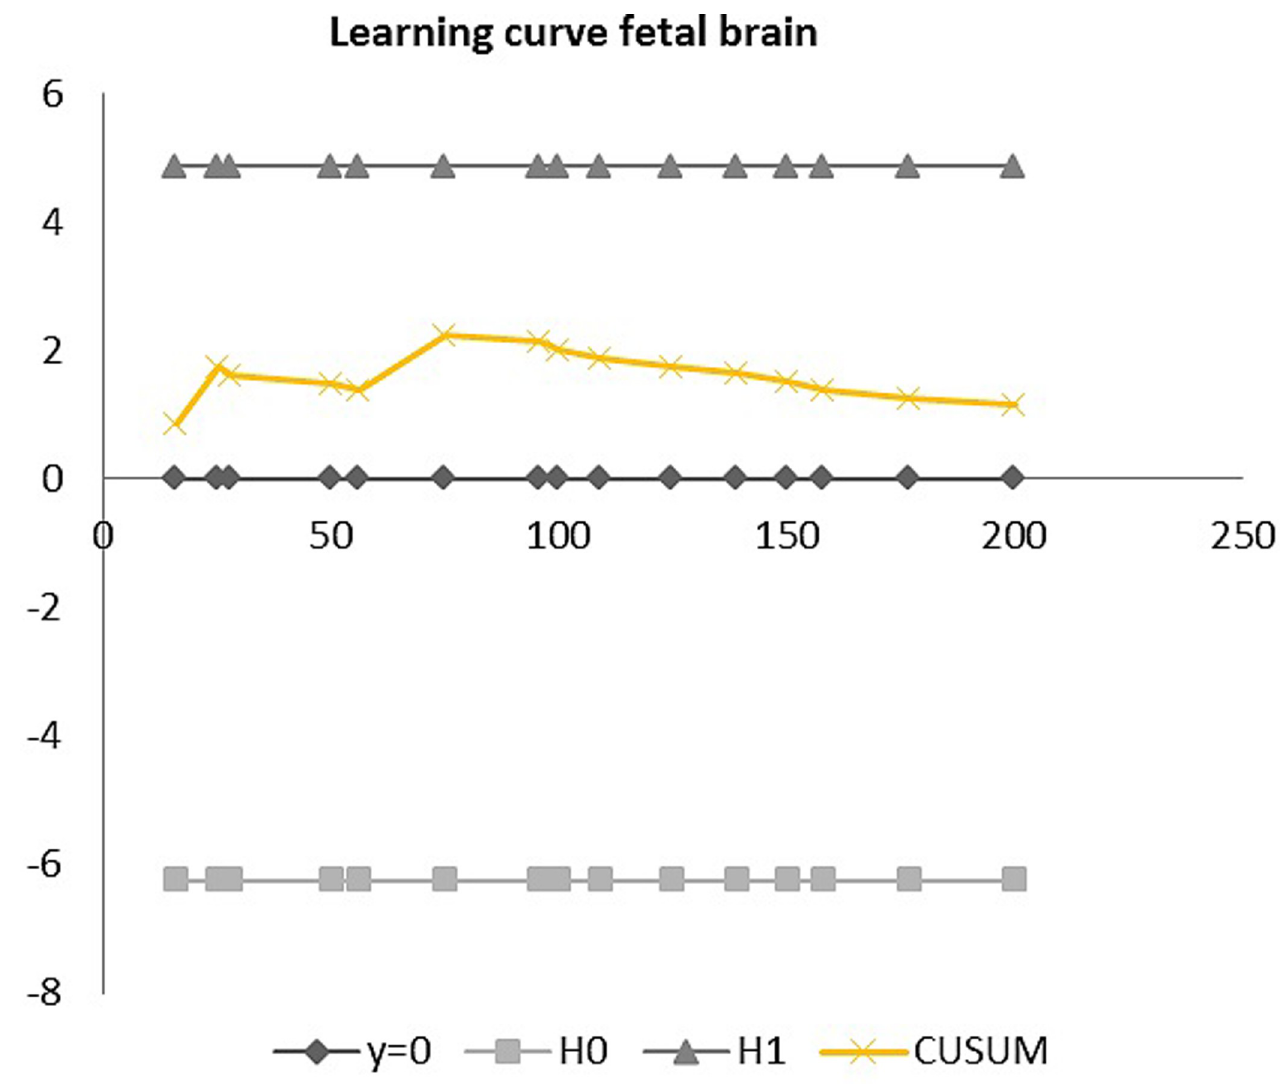
Fig 1. CUSUM analysis showing a learning curve for the fetal brain. Where y = 0 represents the 13-week anomaly scans performed by the sonographers throughout the study period. H0 and H1 represent the lower and upper limits of the CUSUM graph, which should not be crossed by the CUSUM plot (in yellow) for the process to not go out of control. CUSUM represents the learning curve obtained by CUSUM analysis, where a decreasing slope indicates a positive learning process and thus an improvement in performance, as in this